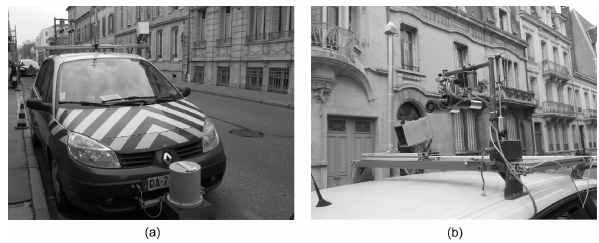
Figure 6. Illustration of a car parked in the street with the radiome- ter on the front bumper (a) , and details of instruments installed on the vehicle